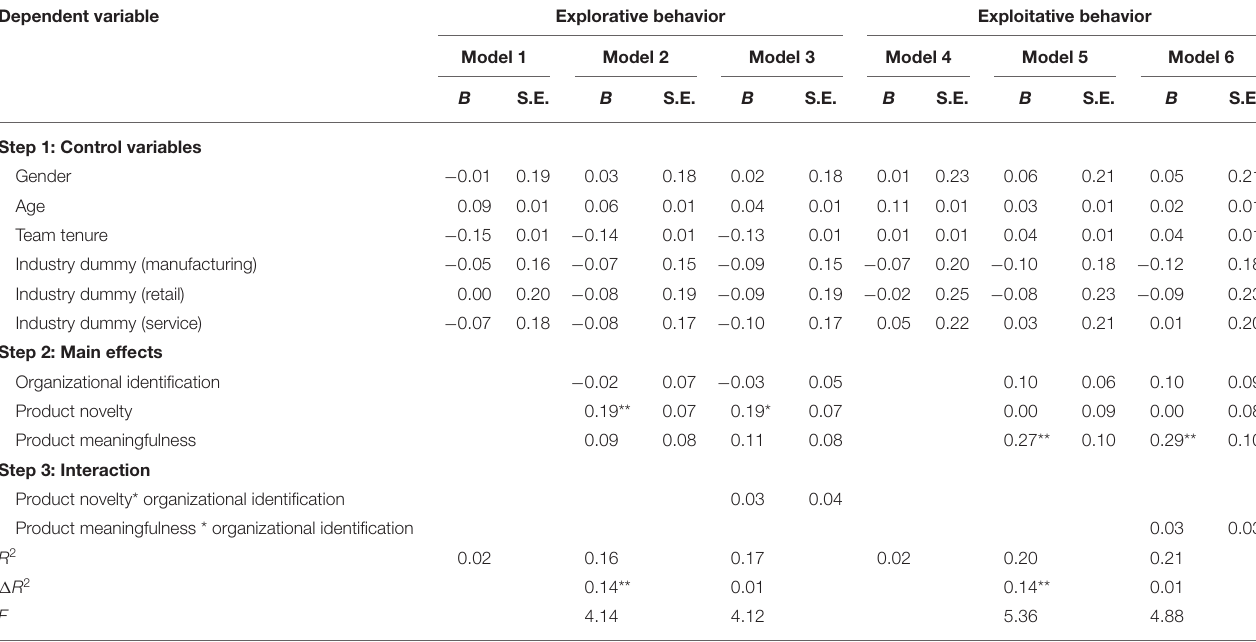
TABLE 3 | Results of hierarchical regression analyses by organizational identification. Dependent